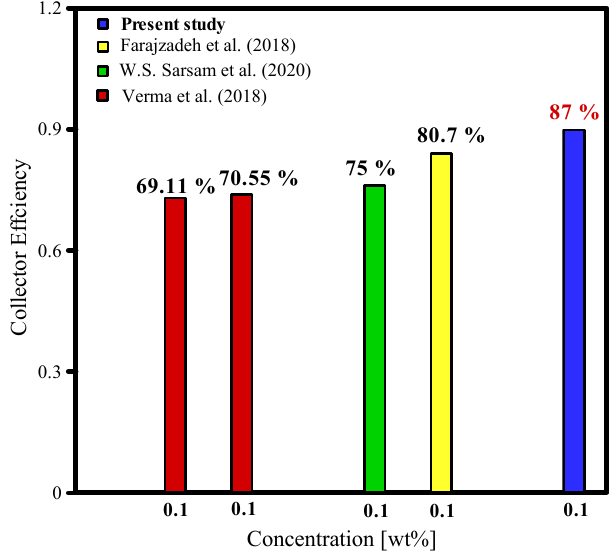
Figure 21. Comparison among experimentally measured thermal efficiency and the results from previous studies on water-based hybrid nanofluids [17,18,41].